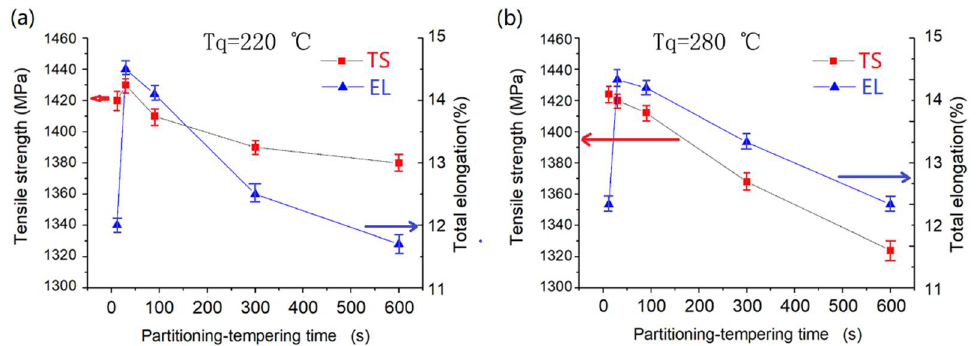
Figure 10. The evolution of ultimate tensile strength (UTS) and total elongation (TEL) of samples as functions of quenching-partitioning time for (a) quenching temperature of 220 °C and (b) quenching temperature of 280 °C.